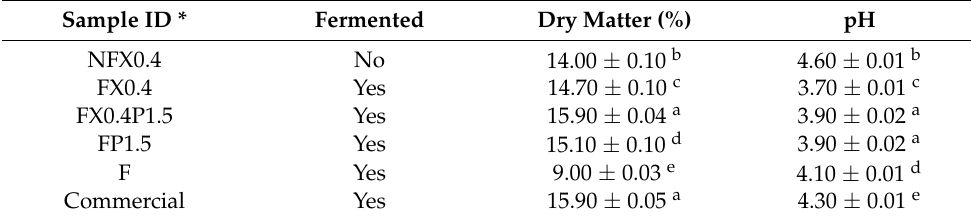
Table 6. Dry matter content and pH of fermented, non-fermented, and commercial samples. Data are presented as mean values of triplicates ± standard